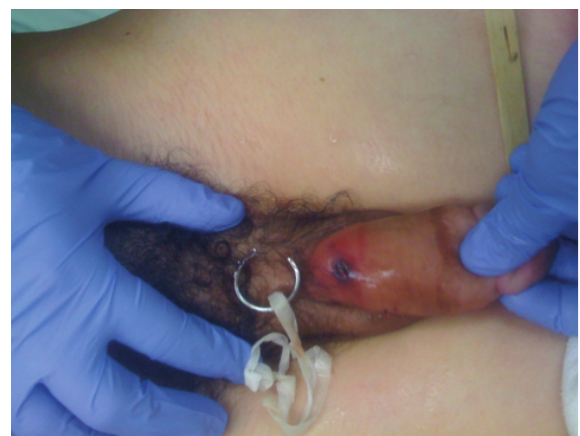
Figure 3: Patient following successful removal of